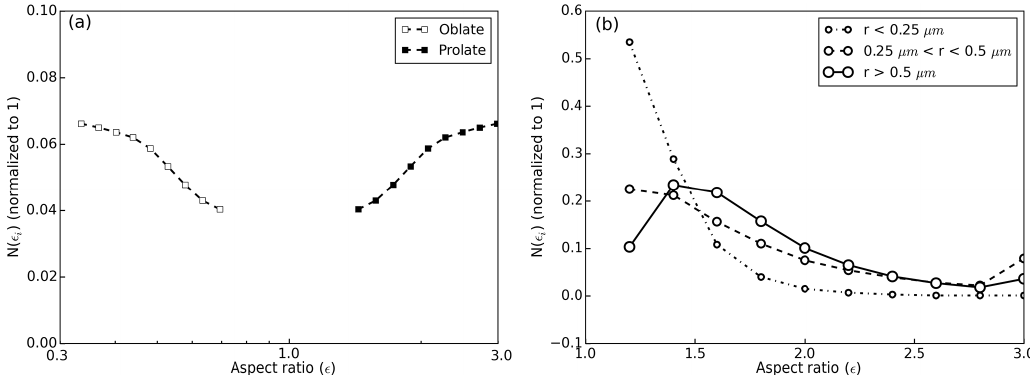
Figure 4. Two spheroidal dust shape distributions models: panel (a) shows aspect ratio distributions from Dubovik et al. (2006). The ln (cid:15) interval is 0.09. Panel (b) shows aspect ratio distributions as a function of the particle radius interval discretized from the measurements of Kandler et al. (2009). The first point of each line covers the measurement data from (cid:15) = 1.0 to 1.3, the last point of each line covers (cid:15) > 2.9 and the other points cover (cid:15) intervals of 0.2 (Koepke et al. 2015).